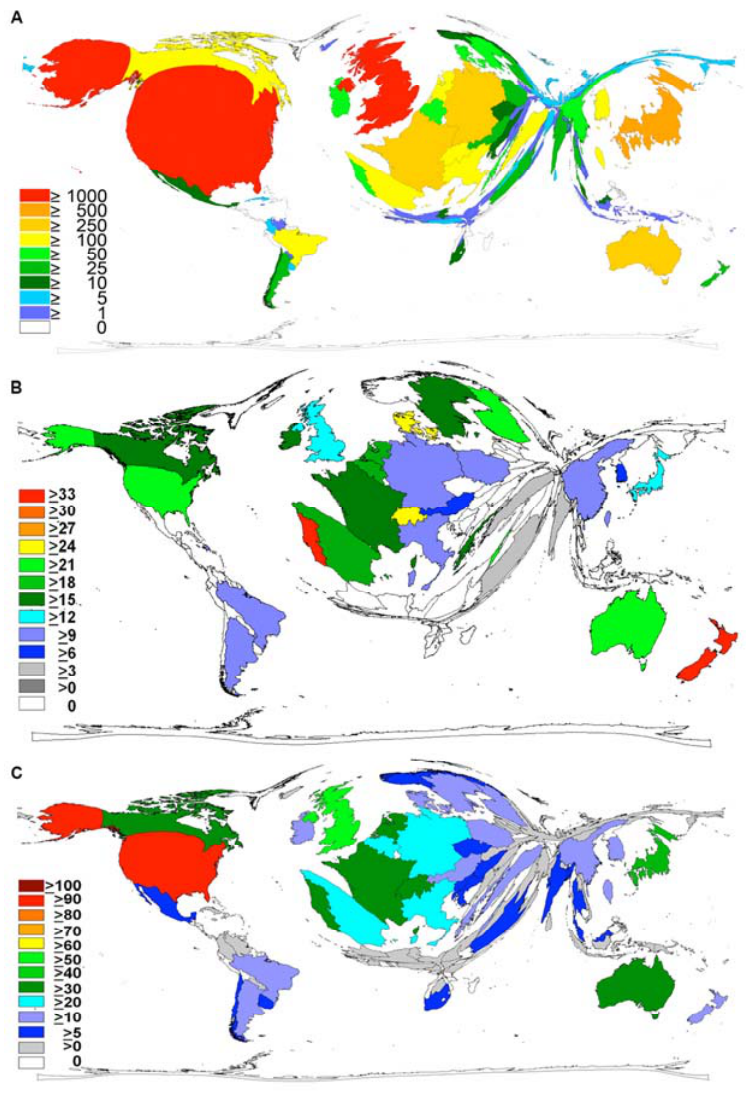
Figure 2. Density-equalizing calculations. ( A ) Map illustrating the number of MRSA-related articles of each country (1961–2007). ( B ) Map illustrating the citation rate of each country’s MRSA-related publications (1961–2007). ( C ) Map illustrating the country-modified h-index of each country for the period 1961–2007. In all maps, the area of each country has been scaled in proportion to the respective